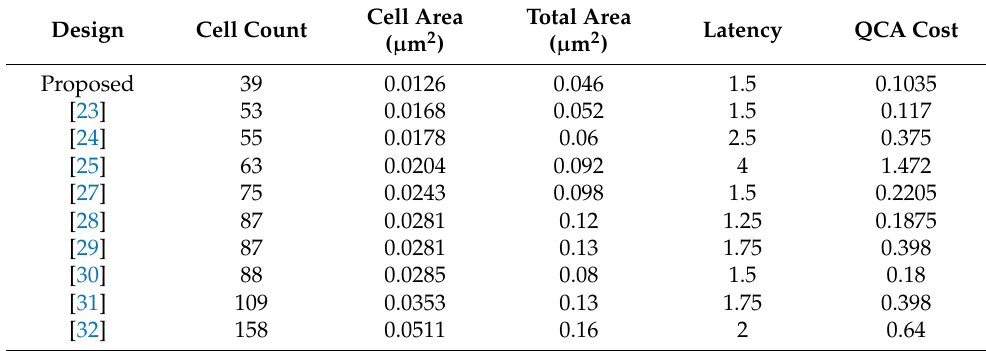
Table 2. Performance Comparison of Memory Cell.